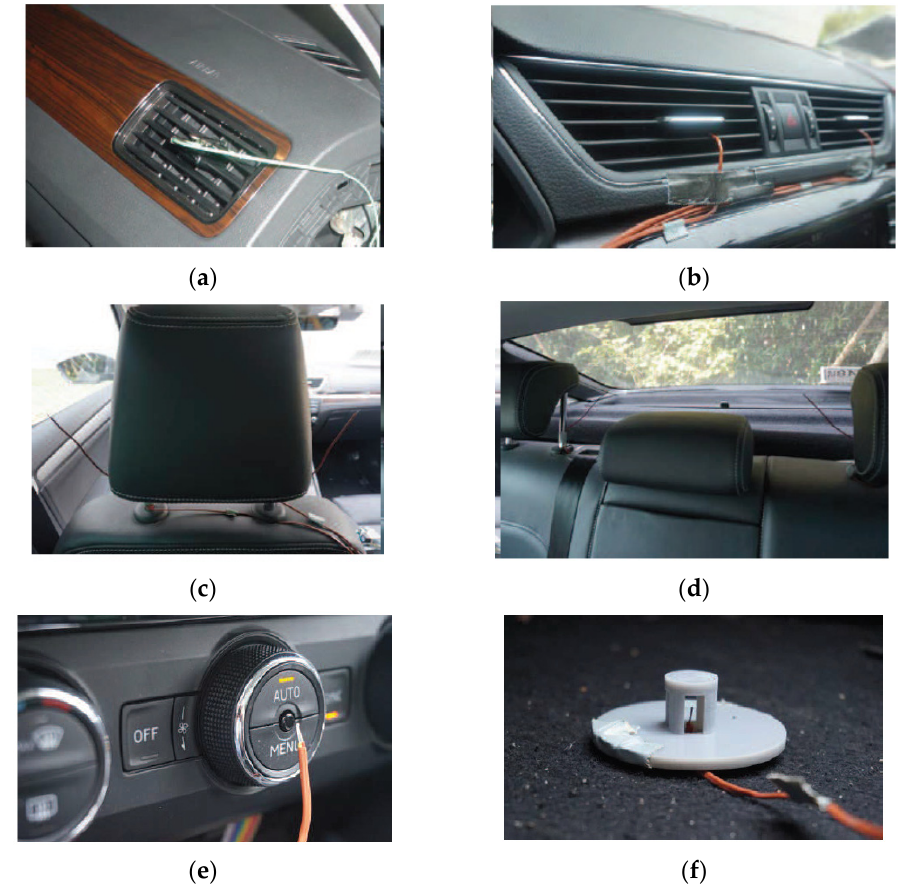
Figure 4. The measurement points of temperature sensor in the cabin. ( a ) Side air outlet; ( b ) Middle air outlet; ( c ) Front seat passenger; ( d ) Rear seat passenger; ( e ) Dashboard area; ( f ) Cabin bottom